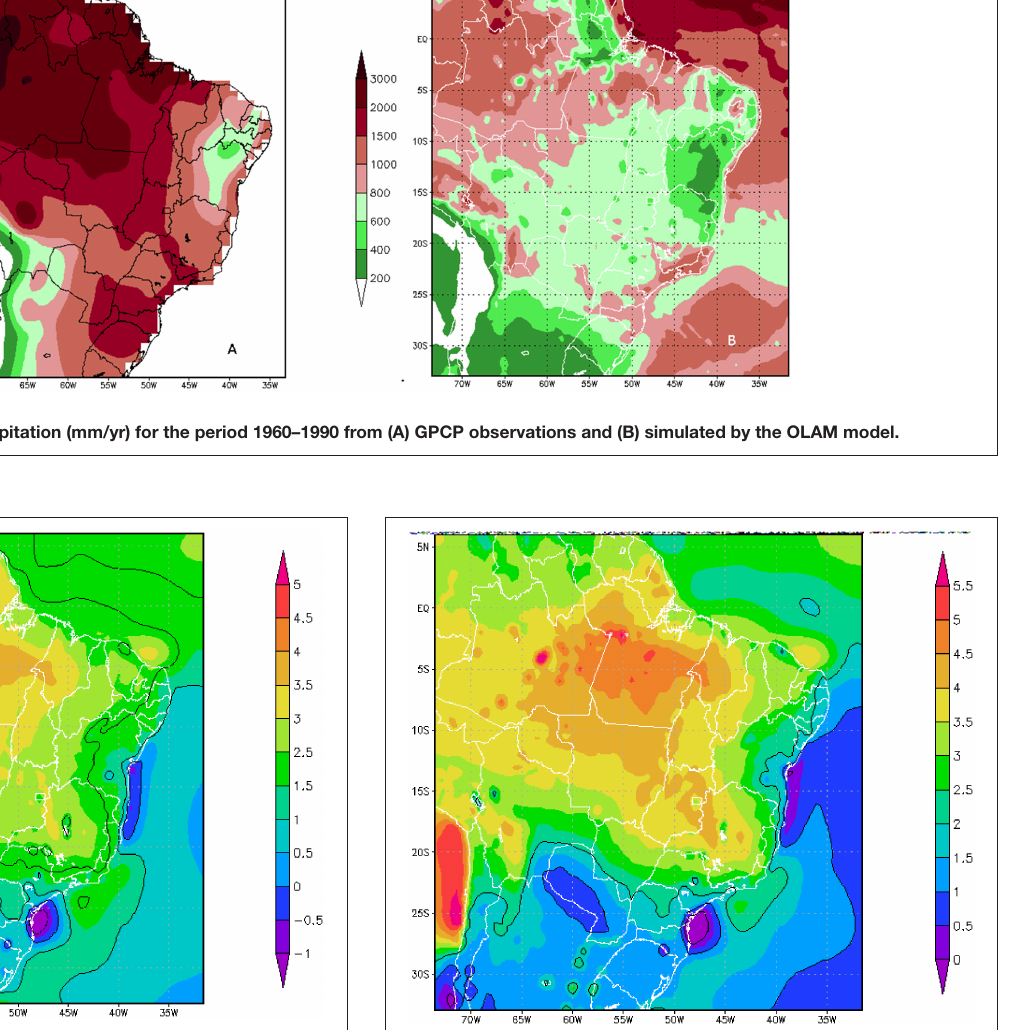
FIGURE 4 | Same as Figure 3, but for temperature changes ( ◦ C) on the period between 2041 and